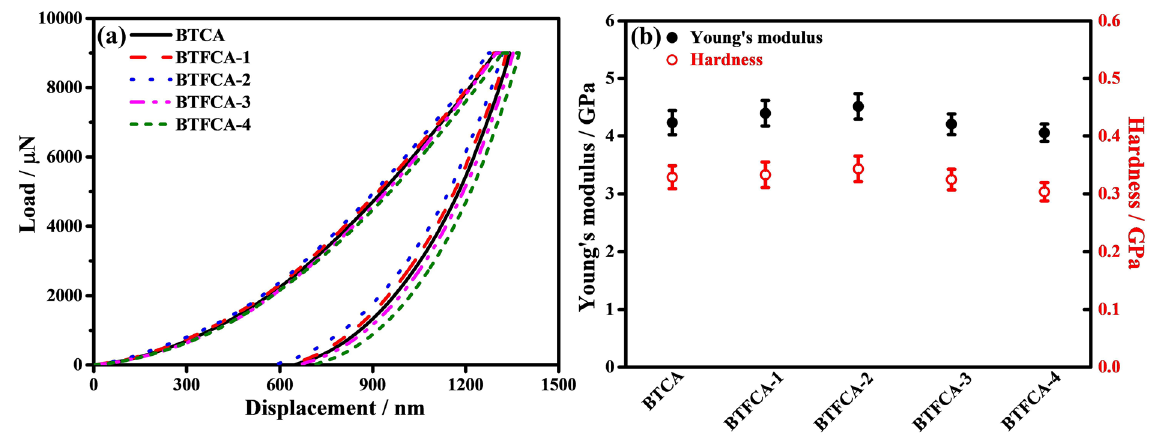
Fig. 8 a Representative load-displacements curves, b Young’s modulus and hardness of BTCA/epoxy and BTFCA/epoxy